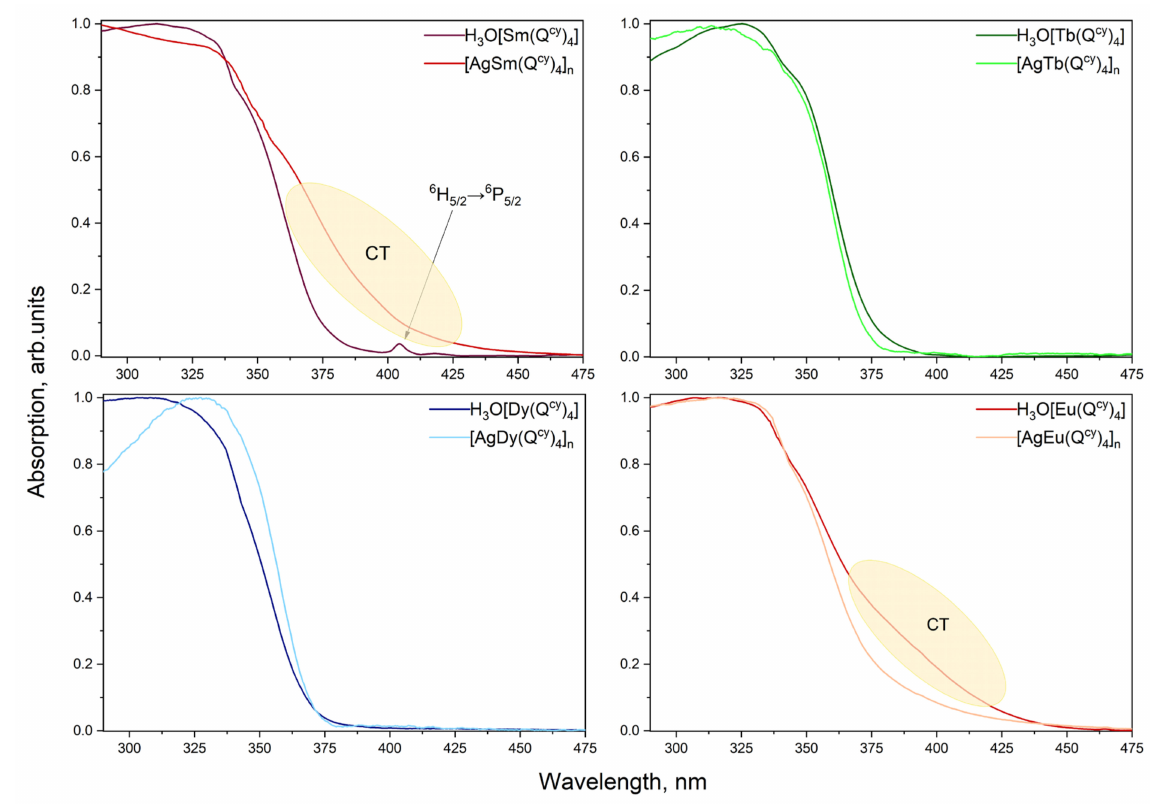
Figure 6. Diffuse reflection spectra for all the complexes